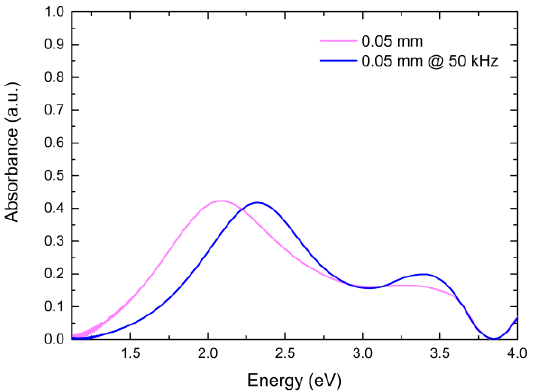
Figure 4. Absorbance spectra for areas of a 13.5 nm Ag film (Ag #1) irradiated with different laser frequency values.